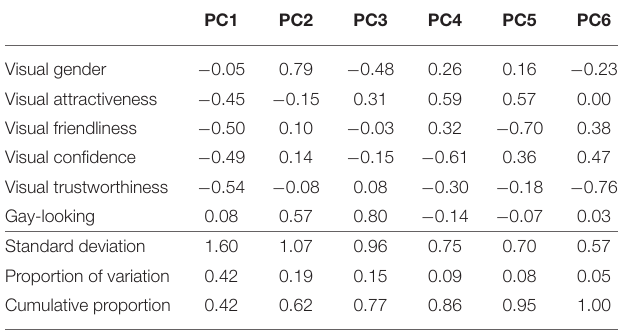
TABLE 7 | Estimates for all predictors in Model 2.